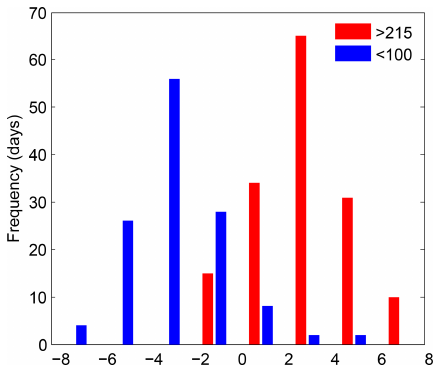
Figure 4. The OWI for MOP (red) and NOP (blue) events during